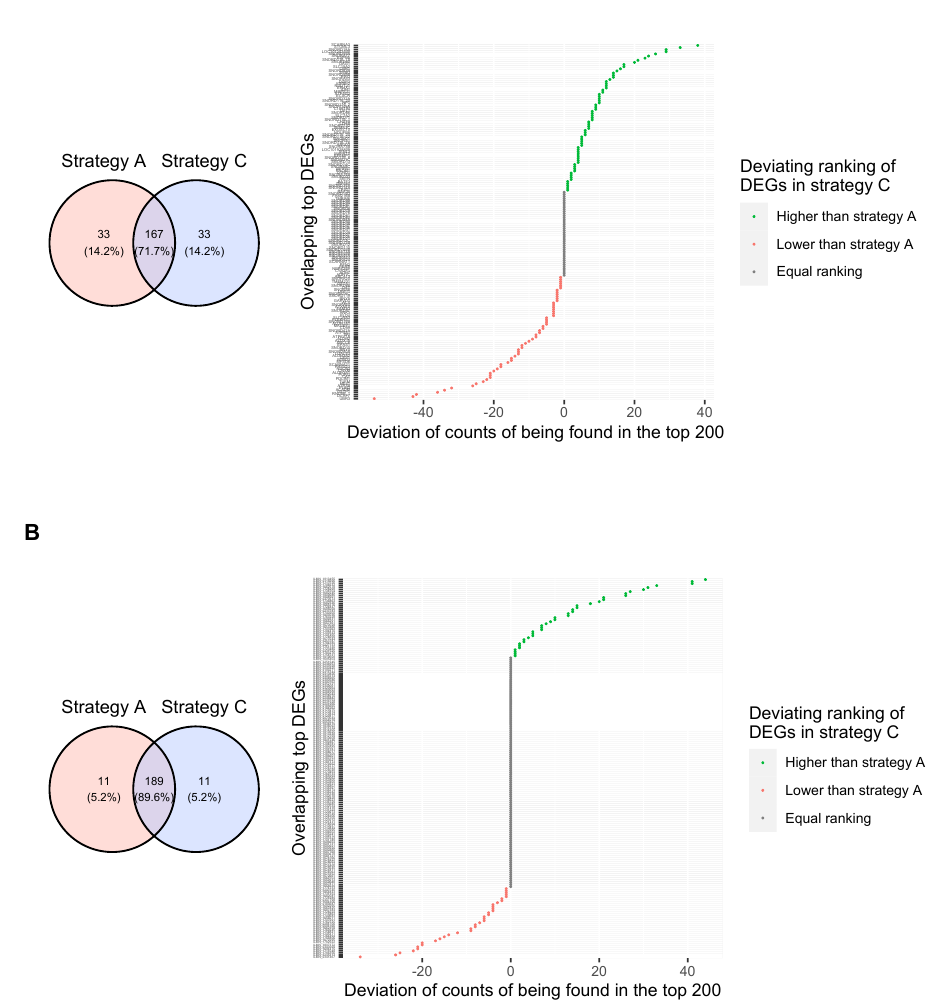
Figure 9. Relative and absolute overlap of the cross-validated top DE genes found in the two real- world datasets before and after outlier removal. Subfigure ( A ) shows the overlap for the top 200 DE genes before and after removing the outliers (strategy A and strategy C) for the SARS-CoV-2 dataset, as well as the deviating ranking of the DE genes. Accordingly, subfigure ( B ) presents the intersection between the top 200 genes found in the WNV dataset before and after removal of the outlier and the divergent ranks of the respective DE